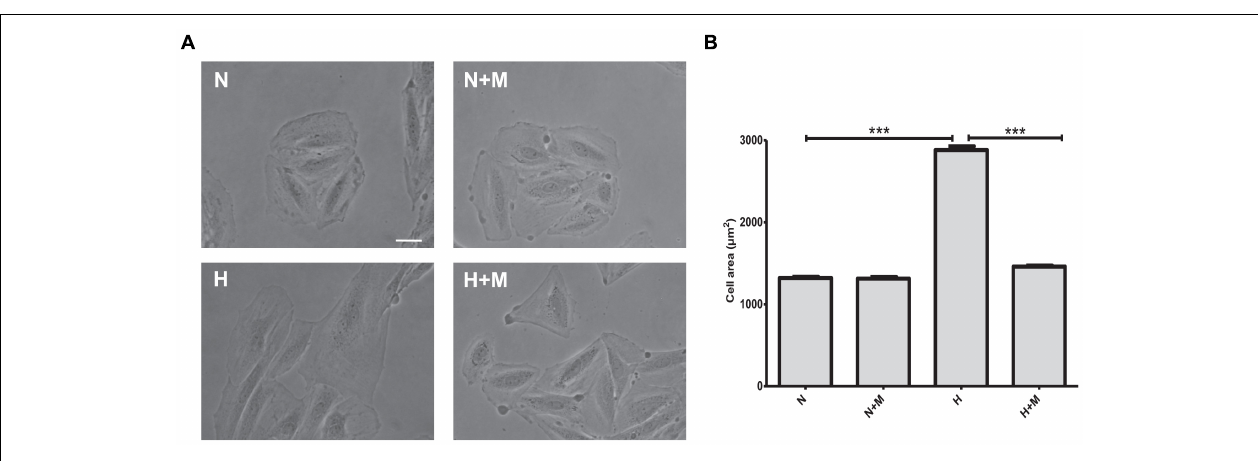
Frontiers in Pharmacology |